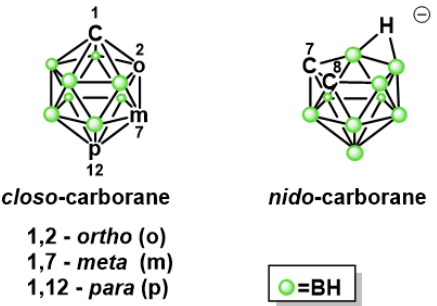
Figure 1. General structure of icosahedral dicarba- closo -dodecaborane ( closo -carborane, C 2 B 10 H 12 ) and 7,8-dicarba- nido -undecaborate anion ( nido -carborane, 7,8-C 2 B 9 H 11 (–1)).